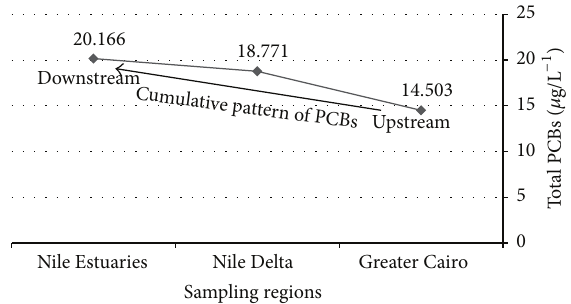
Figure 4: Spatial distribution of total PCBs in waters from the different sampling